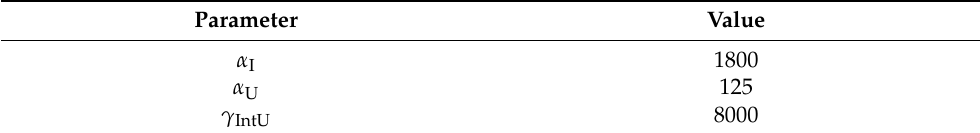
Table 3. Control parameters of the case study.